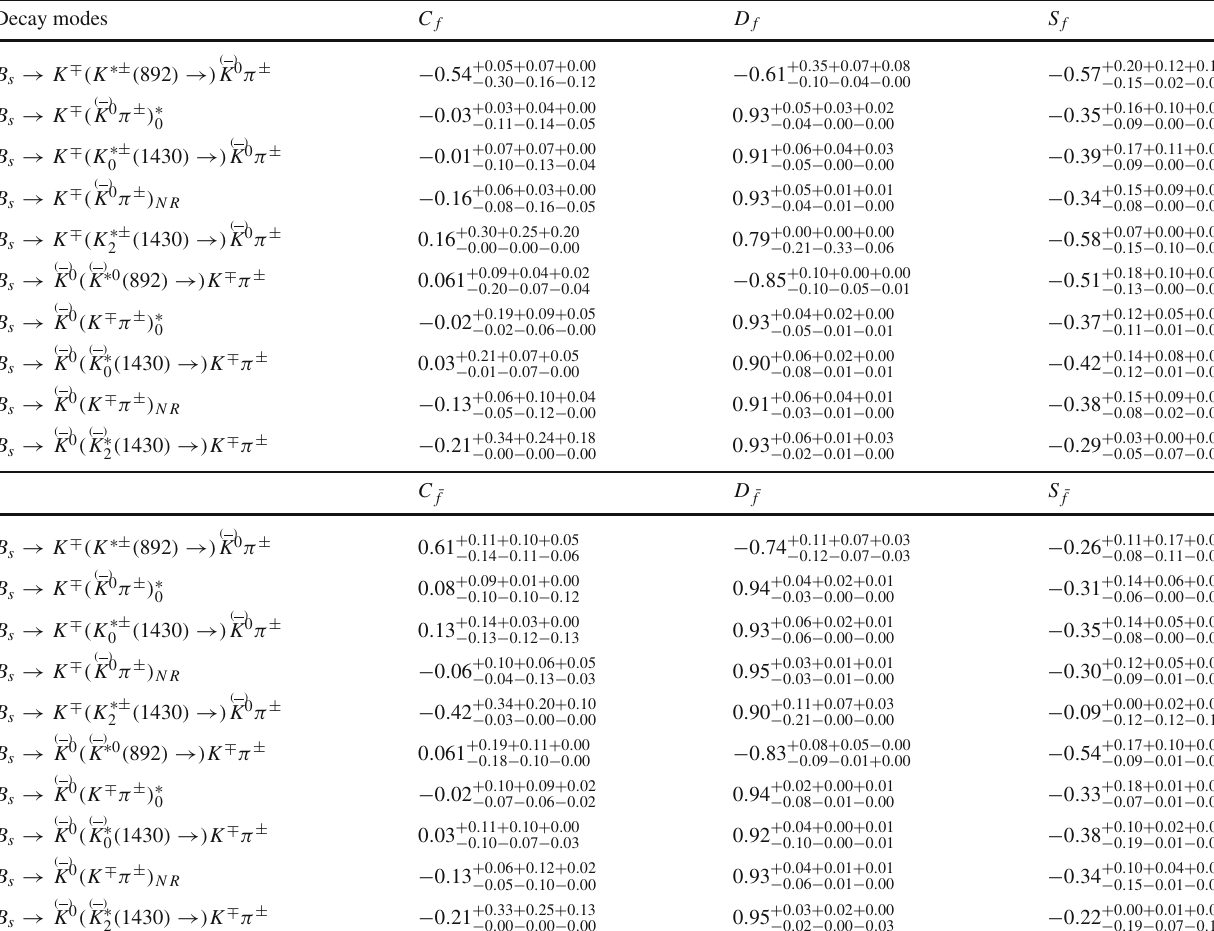
( 1430 ) and K ∗ ( 1430 ) in PQCD approach 0 2